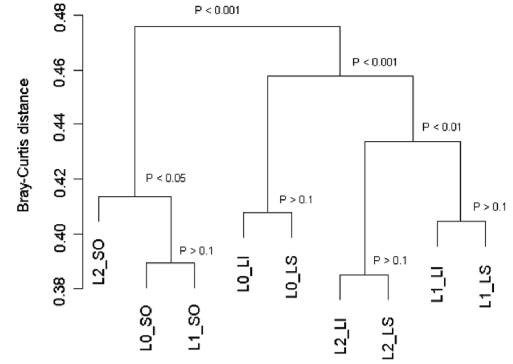
Figure 1. UPGMA cluster of the mean Bray-Curtis distances for the treatment*fraction groups. P: p values derived from MANOVA. L0: control; L1: 0.5 g/d yeast; L2: 5 g/d yeast; LI: liquid fraction; LS: whole rumen content; SO: solid fraction.